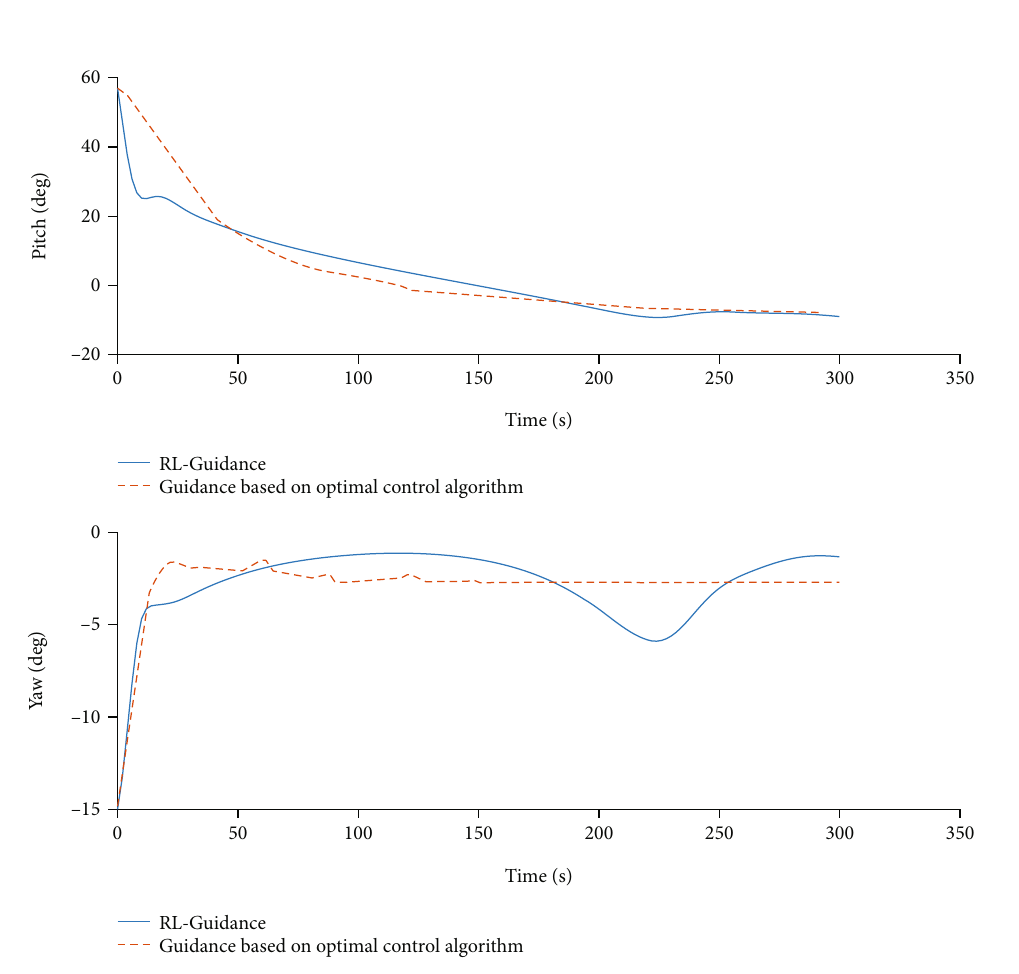
RL-Guidance Guidance based on optimal control algorithm